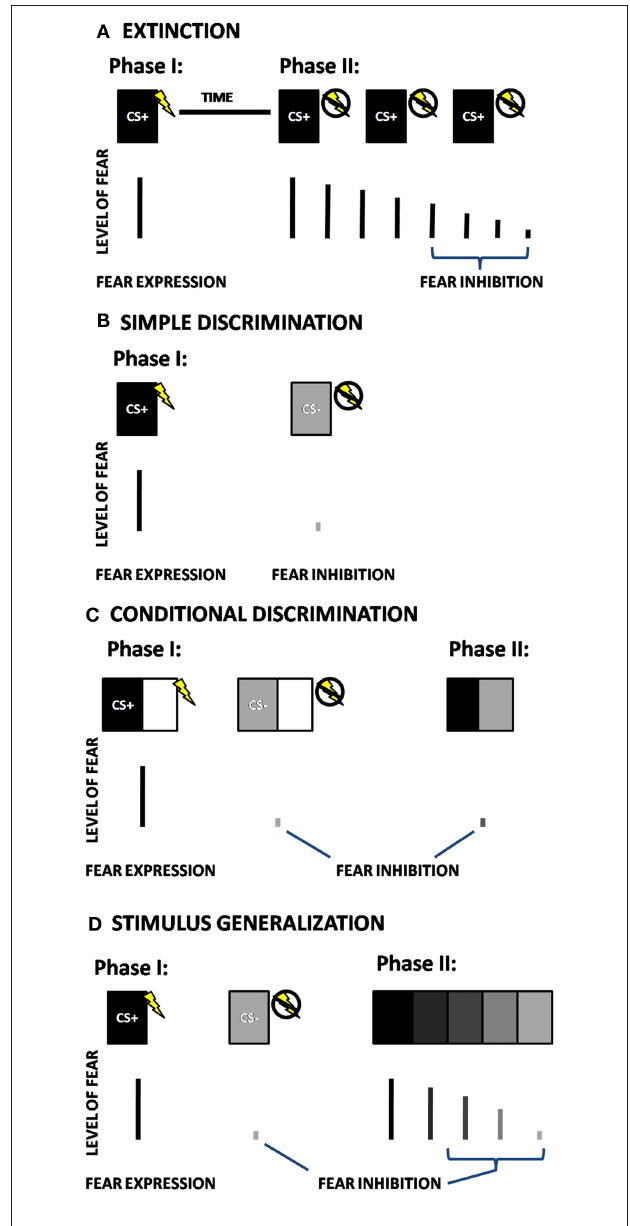
Figure 1 | Schematic depictions of four different fear-inhibition paradigms; (A) extinction, (B) Simple Discrimination, (C) Conditional Discrimination, and (D) Stimulus generalization. CS + = Reinforced Conditioned Stimulus; CS − = Non-reinforced Conditioned Stimulus. In fear extinction paradigms (A) , a stimulus that was paired with an aversive stimulus (the CS + ) during the initial phase is then repeatedly presented without the US in the next phase of the experiment, so that it no longer elicits a fear response. In the simple discrimination paradigm (B) , the CS + is intermingled with a separate stimulus that is not paired with the US (CS − ). In a conditional discrimination experiment (C) , the US occurs depending on the presence of the CS + when it is combined with a neutral (X) cue, which is also combined with the CS − to predict the absence of the US. In the next phase of the experiment, presentation of CS + and CS − together, without the shared cue (X) results in a reduced fear response compared to the response to CS + . In a stimulus generalization experiment (D) , after the initial conditioning, the second phase of the experiment presents iterations of CSs that differ from the CS + in small increments. The number of degrees required for discrimination is an indication of cue